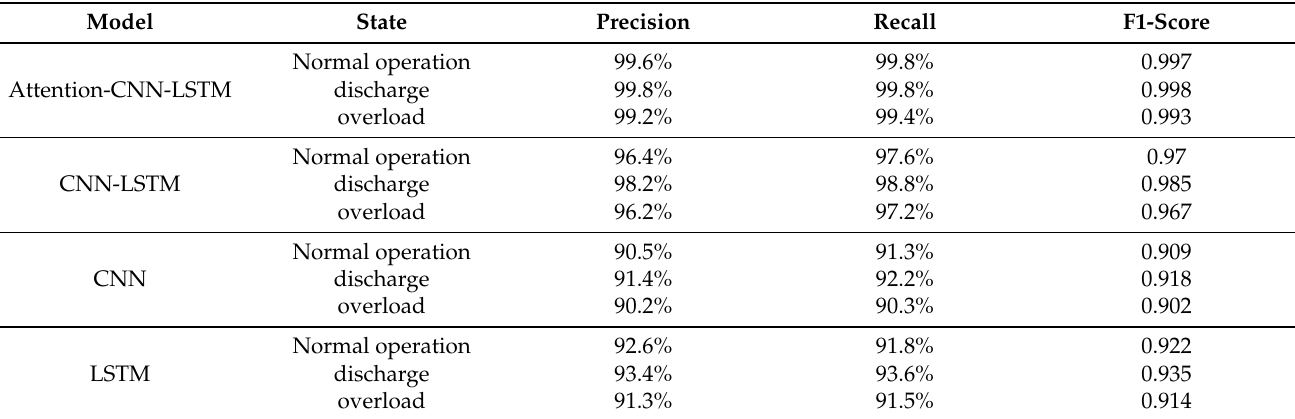
Table 2. Parameters of performance